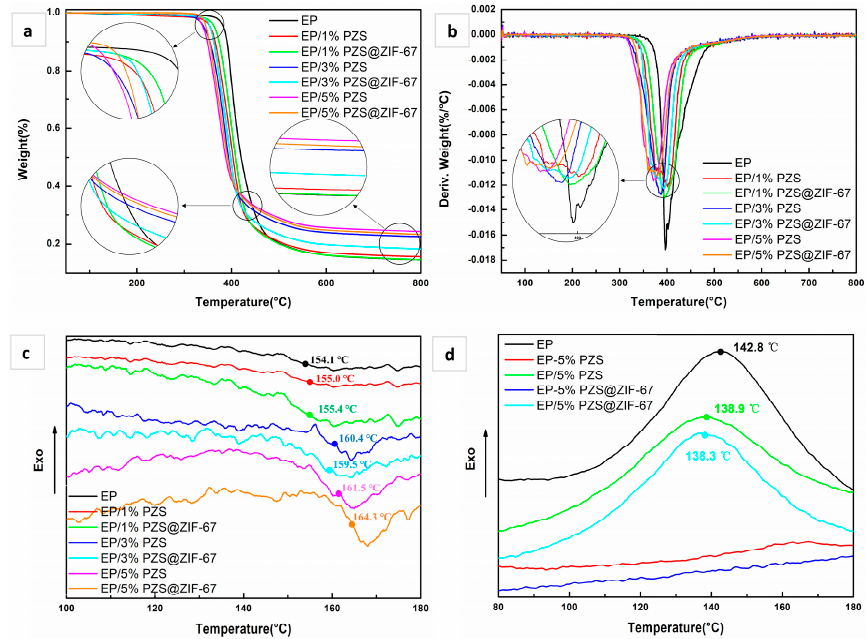
Figure 6. TGA ( a ), DTG ( b ), DSC ( c ), and DSC during curing process; ( d ) curves of pristine EP and its composites.